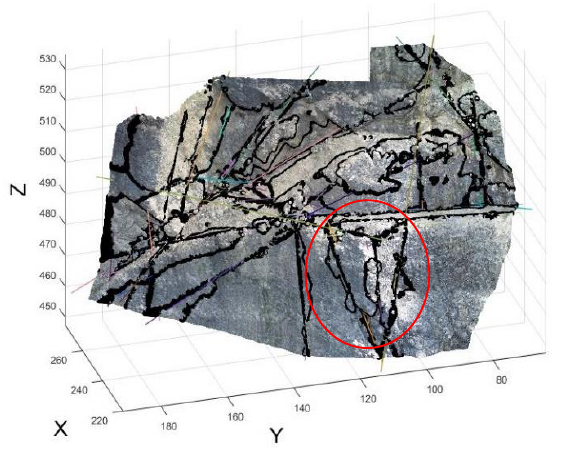
Figure 7. Intersection of 12 planes with the point cloud, considering 500 inliers in RANSAC algorithm. Black points in the Fig. 6 are due to the intersection of the main fracture planes and the point cloud. Obviously to show more detailed results we have to change our parameters. As you can see in both Fig. 6 and Fig. 7, there is a red circle which identifies the intersection of three planes and a rock mass is located there. Therefore, the rock mass has a high potential of falling down.